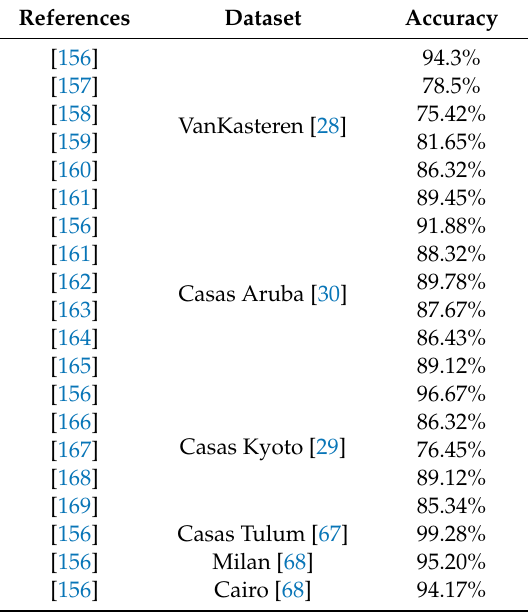
Table 10. Details of the sub-clustering